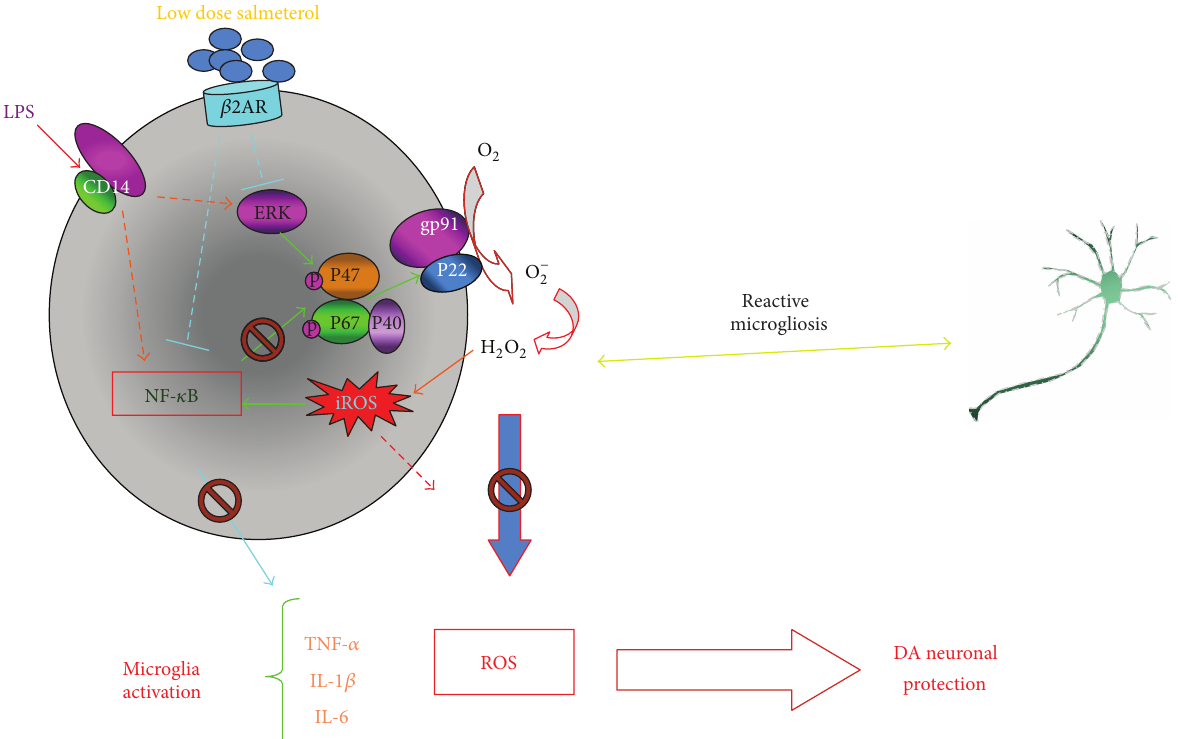
Figure 2: Molecular mechanism of the inhibitory function of salmeterol-mediated 𝛽 2AR